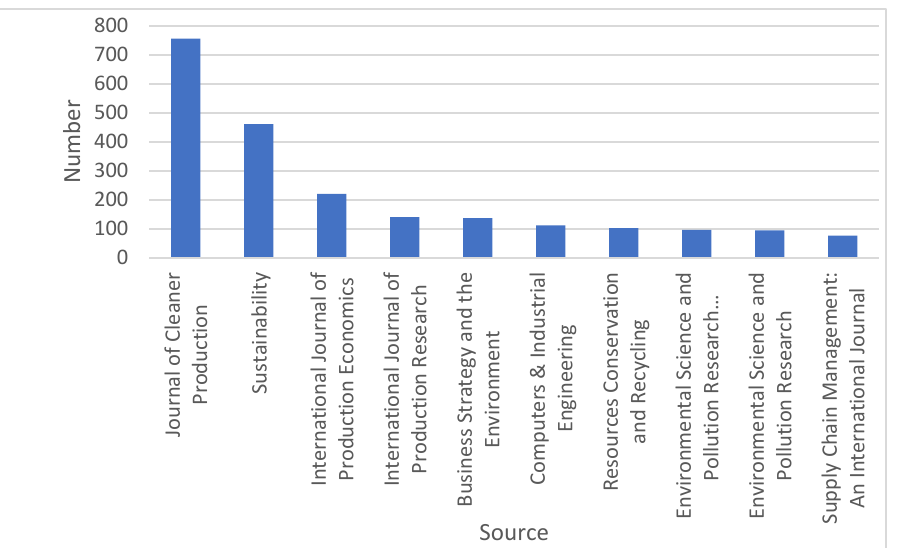
Figure 3. Source distribution of literature and periodicals.